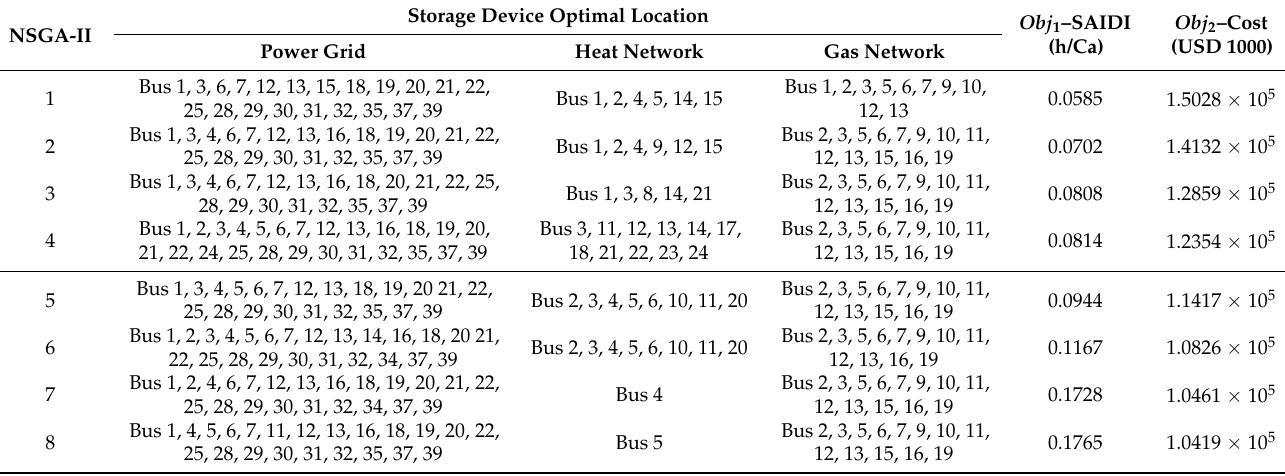
Table 7. NSGA-II optimization result.